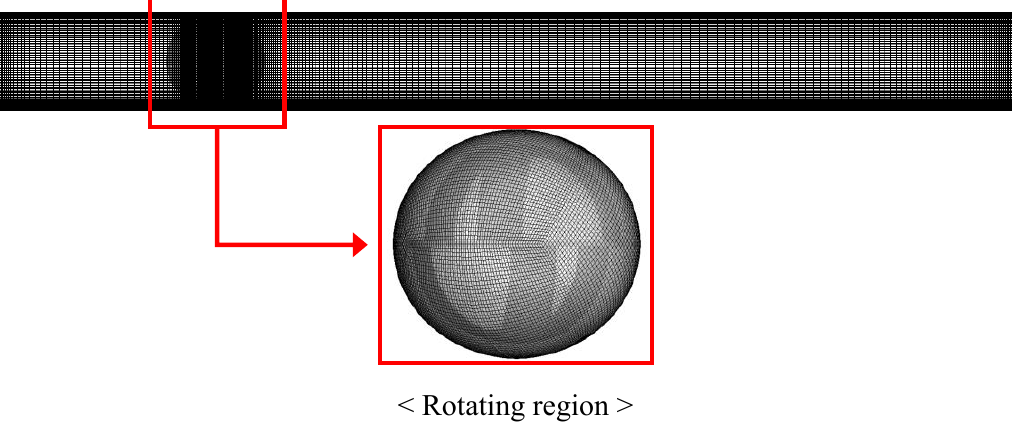
Figure 5. Computational domains and mesh.